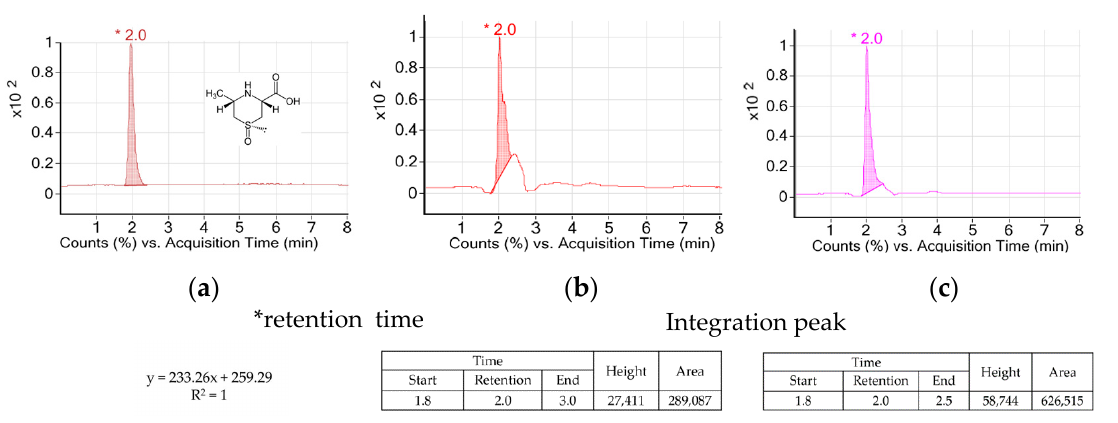
Figure 2. TIC chromatogrmas of cycloalliin in ( a ) standard, ( b ) A. hookeri leaves extract and ( c ) A. hookeri roots extract analyzed by LC/MS.